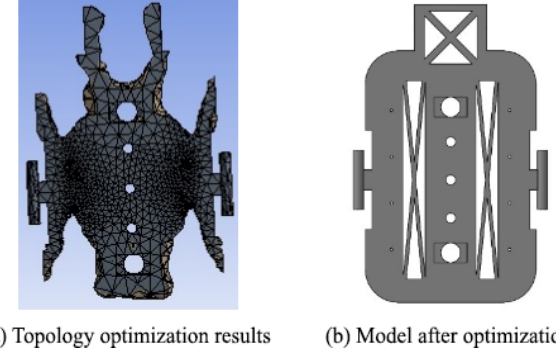
Figure 12. The frame optimization